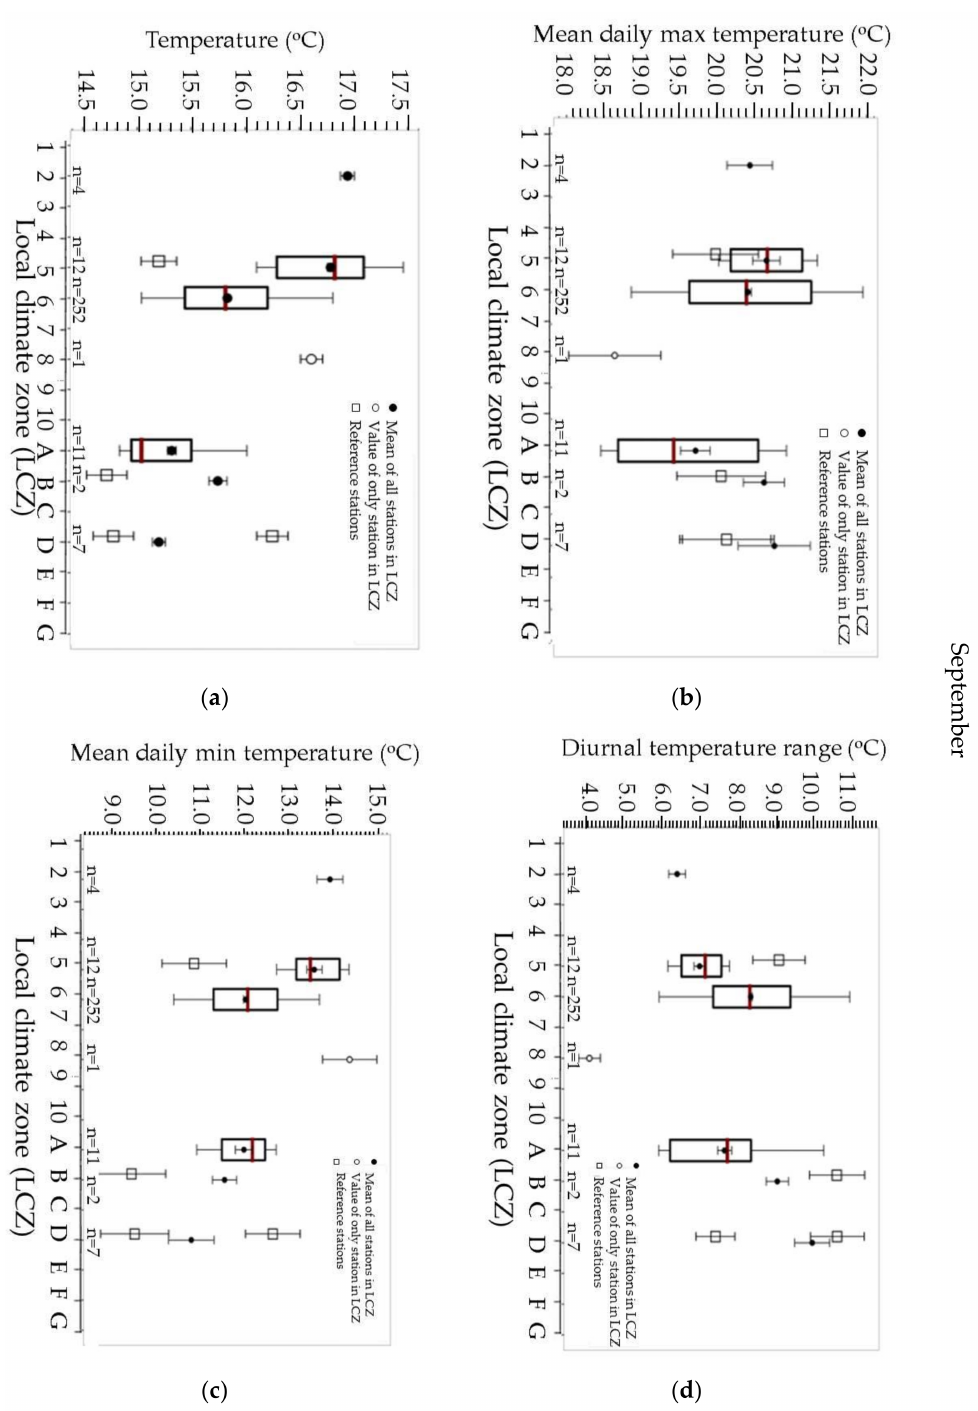
Figure A2. Local climate zone (LCZ) temperature characteristics in September 2018: ( a ) is the mean temperature over the entire month, ( b ) is the mean daily maximum temperature, ( c ) is the mean daily minimum temperature, and ( d ) is the mean diurnal temperature range. LCZs associated with urban landscapes (LCZs 1-10) are on the left side and those associated with rural landscapes (LCZs A–G) are on the right side. n represents the number of valid stations in that LCZ. Filled dots represent the mean of all Netatmo stations in each LCZ, unfilled dots represent the value of the only Netatmo station in an LCZ and squares represent values of reference stations. Box plots are also displayed for LCZs with more than ten stations present. The maroon central line represents the median, the upper and lower bands of the box are the 75th and 25th percentiles and the upper and lower whiskers are the 95th and 5th percentile. The method of error calculation of the means is shown in Appendix